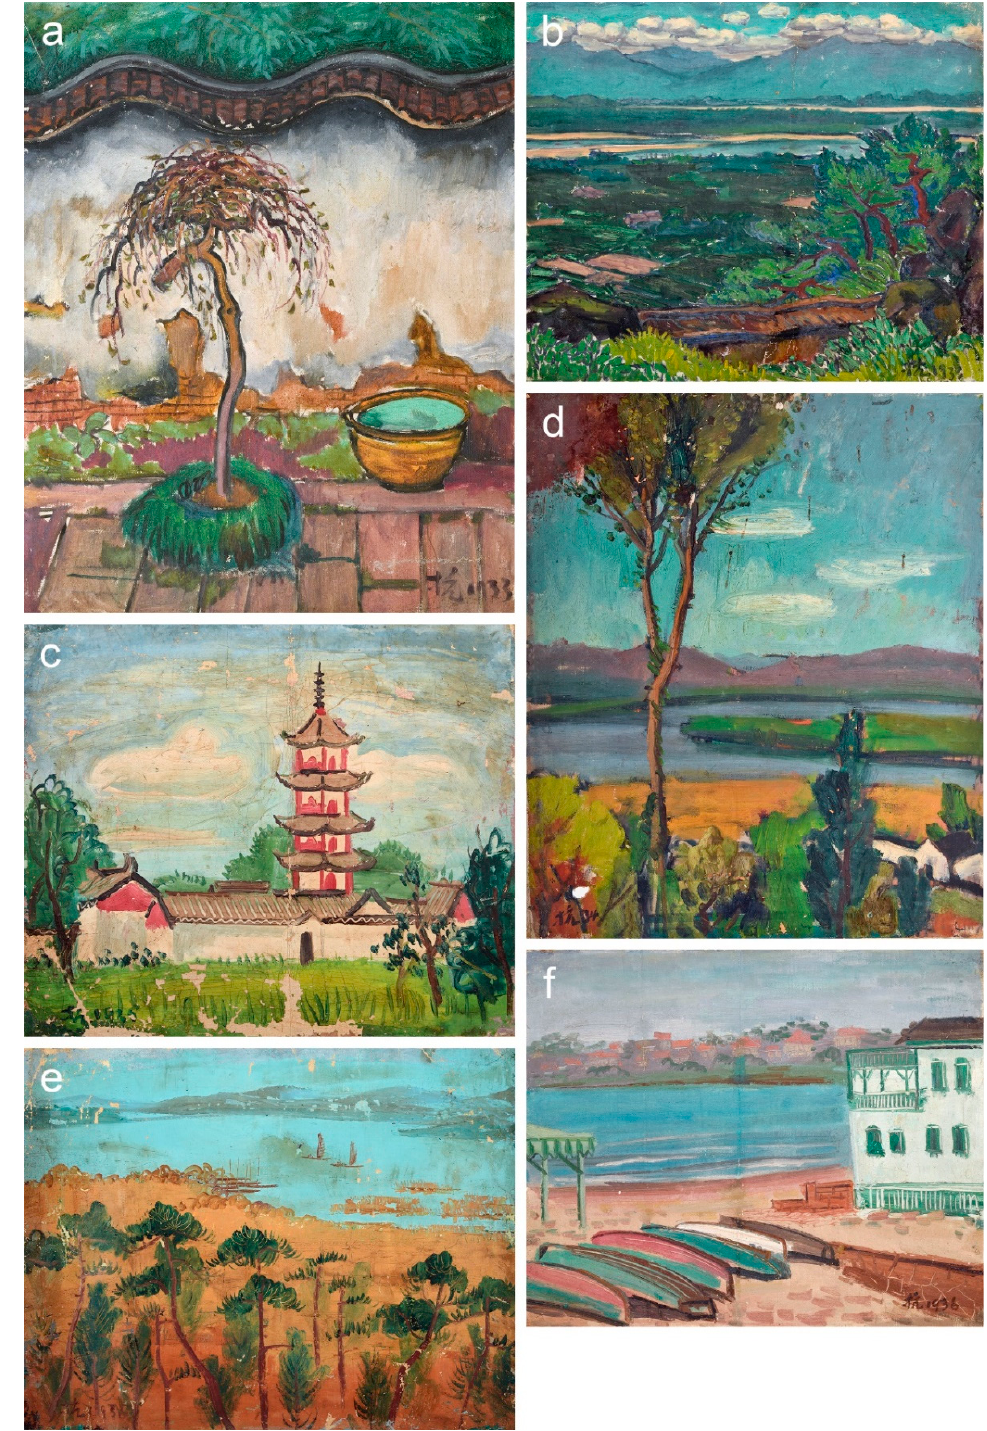
Figure 3. Paintings by Liu Kang from the Liu family collection. ( a ) Courtyard, Shanghai , 1933, oil on canvas, 73 × 60 cm; ( b ) Countryside landscape , 1933, oil on canvas, 45 × 54.5 cm; ( c ) Pagoda , 1936, oil on canvas, 45 × 55 cm; ( d ) Rustic landscape , 1934, oil on canvas, 54 × 46 cm; ( e ) Seascape , 1936, oil on canvas, 50 × 64 cm; ( f ) Seaside near Shanghai , 1936, oil on canvas, 46 × 55 cm. Liu Kang family collection. Images courtesy of the Liu family.